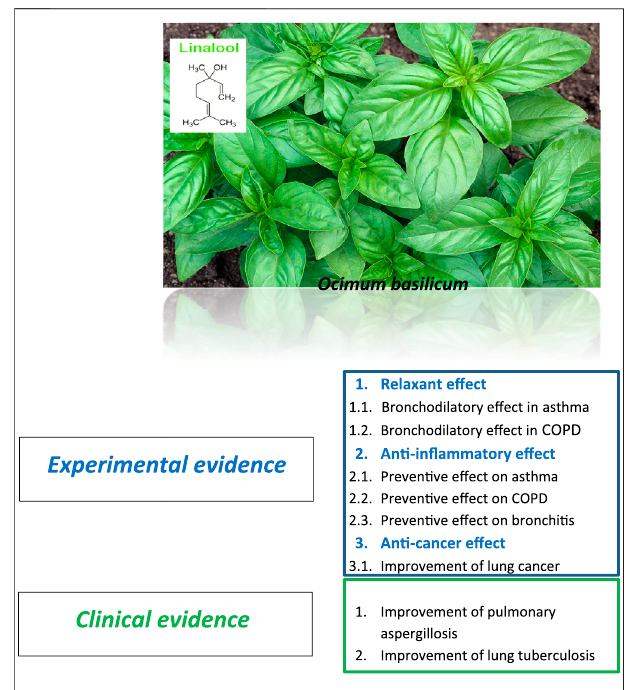
FIGURE 4 | Summary of O. basilicum effect on respiratory